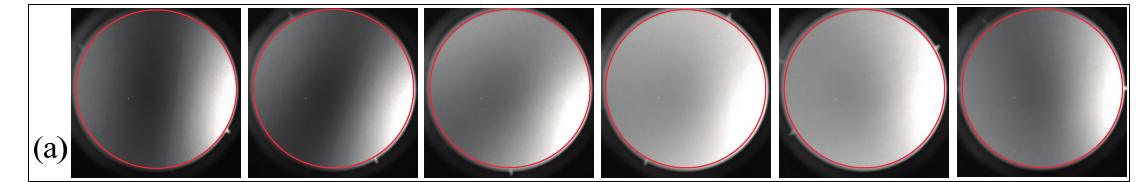
plot of measured ˆ φ of the sky; ( c ) Polarization patterns of φ based on Rayleigh scattering theory; ( d ) Contour plot of measured ˆ d of the sky; ( e ) Polarization patterns of d based on Rayleigh scattering